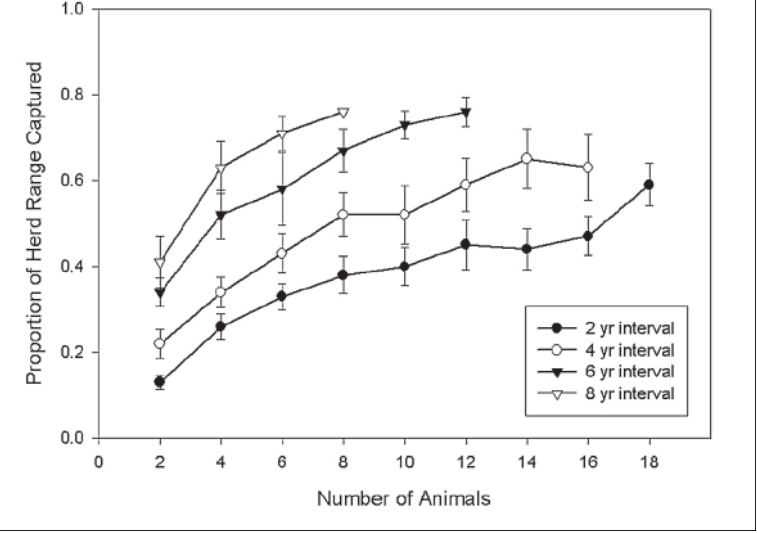
Fig. 4. Trade-offs between length of monitoring interval and number of caribou moni- tored with description of the population range for the Red Wine Mountain herd, Labrador. Each curve represents a monitoring interval of a different length. Values represent averages calculated from twenty repetitions randomly sampled from potential combinations of sample size/interval length